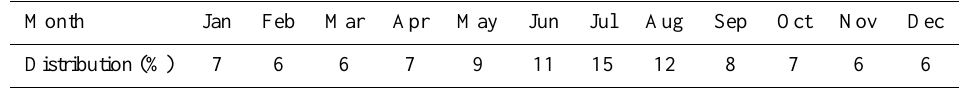
Table 4. Estimated monthly variation in groundwater abstraction.